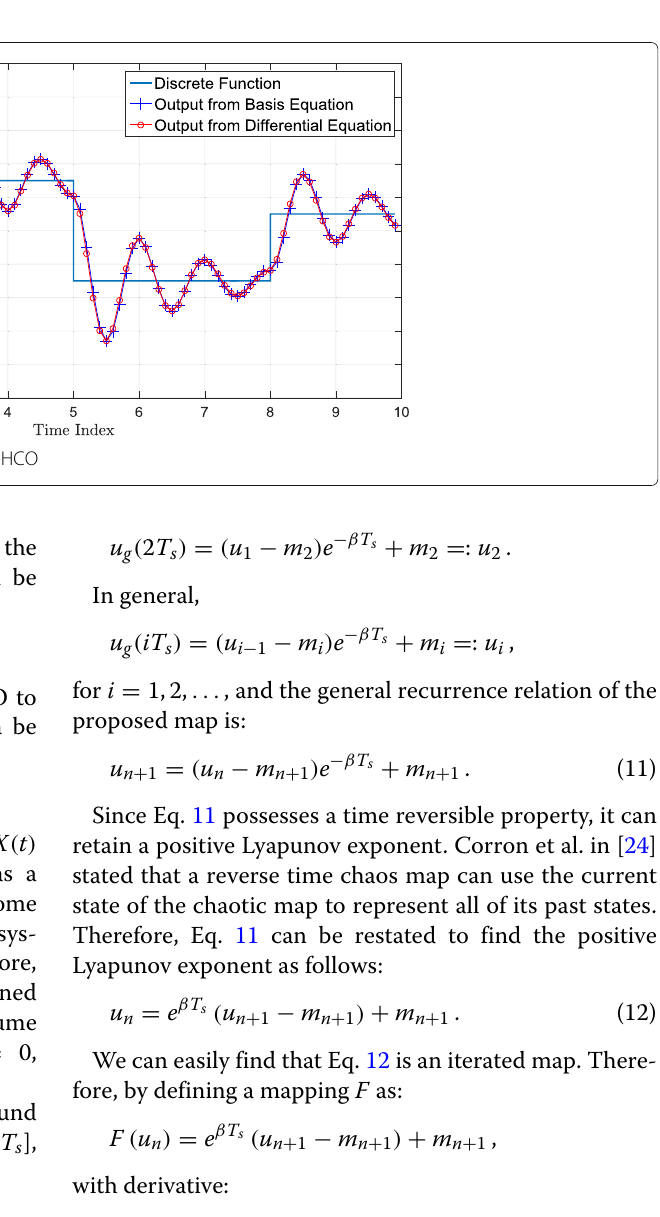
Fig. 2 Simulation of basis function and differential equation of GM-HCO